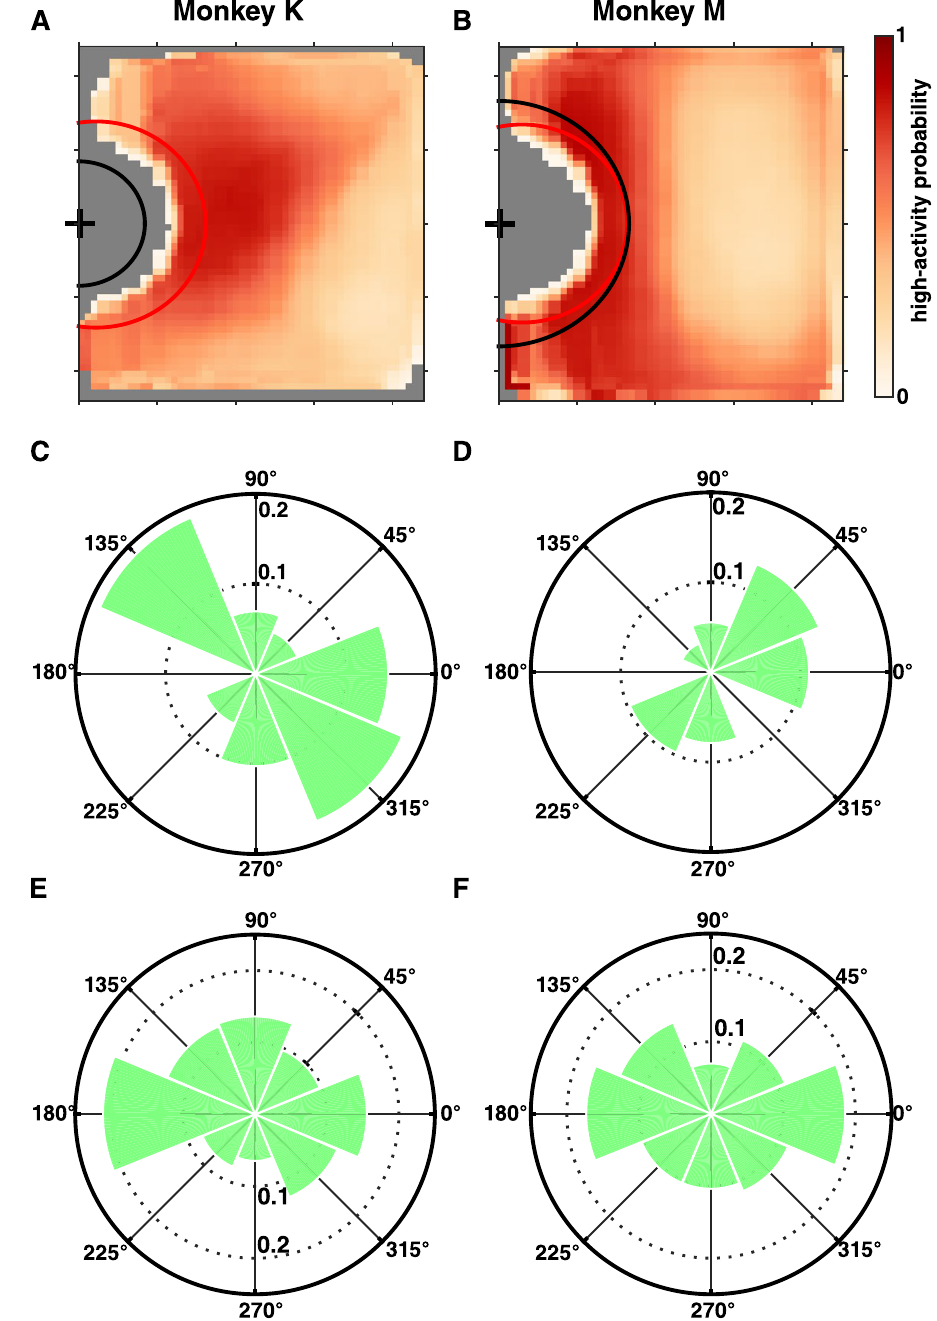
Figure 3. Place fields and preferred-directions for the neuronal ensembles. ( A , B ) Heatmaps of ensemble- average place fields for monkey K ( A ) and monkey M ( B ); plots represent averages across all sessions. Only position-preferring neurons were included. Each neuron’s place field was defined as the room locations where the neuron’s tuning function (as fitted by GAM) exceeded the median value over all room locations. A histogram of place-fields was constructed from all position-preferring cells’ place-fields and normalized by the number of position-preferring cells in each session. These session histograms were then averaged to produce the final heatmap. ( C , D) Circular histograms of preferred α directions averaged over sessions for monkey K ( C ) and monkey M ( D ). For each session, the preferred α directions of all orientation-preferring neurons were extracted from their α -tuning curves (as fitted by GAM). The preferred directions were then represented as circular histograms. Radial direction represents proportion of neurons. (E , F) Circular histograms for β . Conventions as in ( C , D